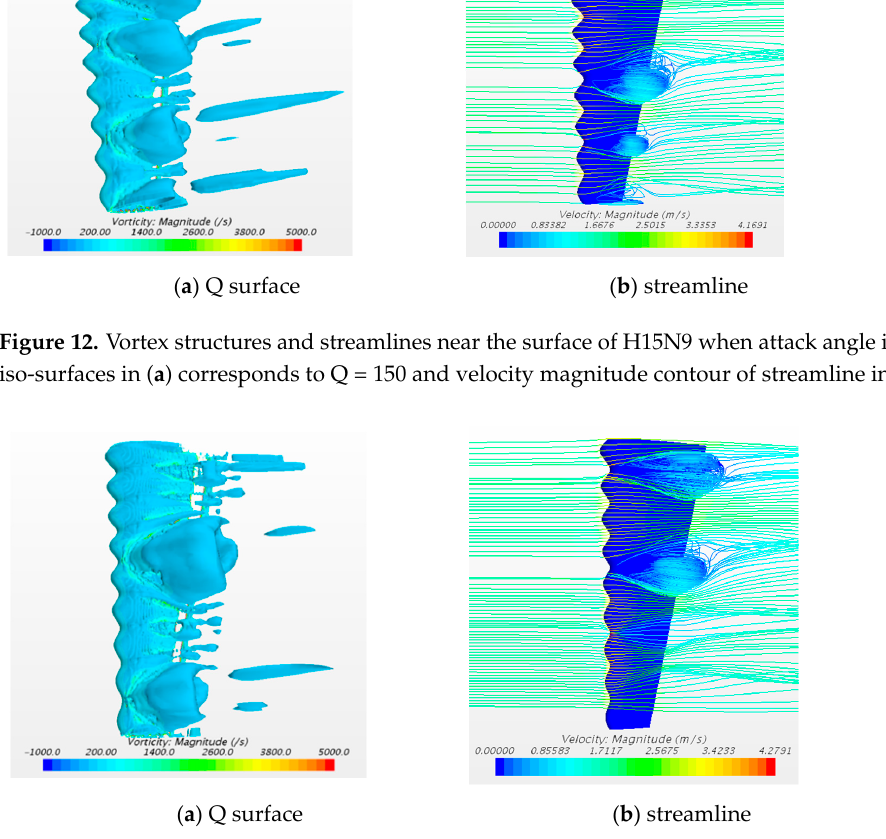
Figure 13. Vortex structures and streamlines near the surface of H10N9 when attack angle is 16° (the iso-surfaces in ( a ) corresponds to Q = 150 and velocity magnitude contour of streamline in ( b )).